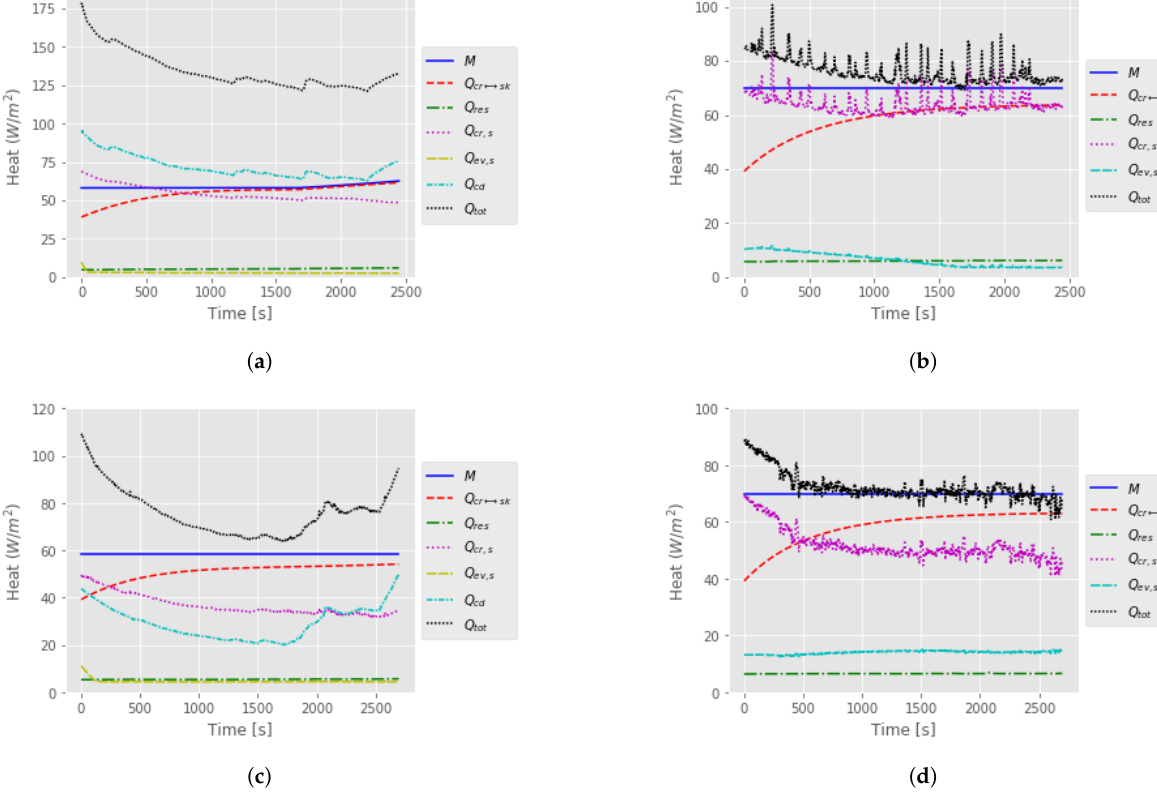
Figure A2. Computed average metabolic rates of heat production, rates of heat exchange and rates of heat loss for Meas. 1 and 3 and both sitting and standing positions. ( a ) Meas. 1 (sitting positions). ( b ) Meas. 1 (standing positions). ( c ) Meas. 3 (sitting positions). ( d ) Meas. 3 (standing